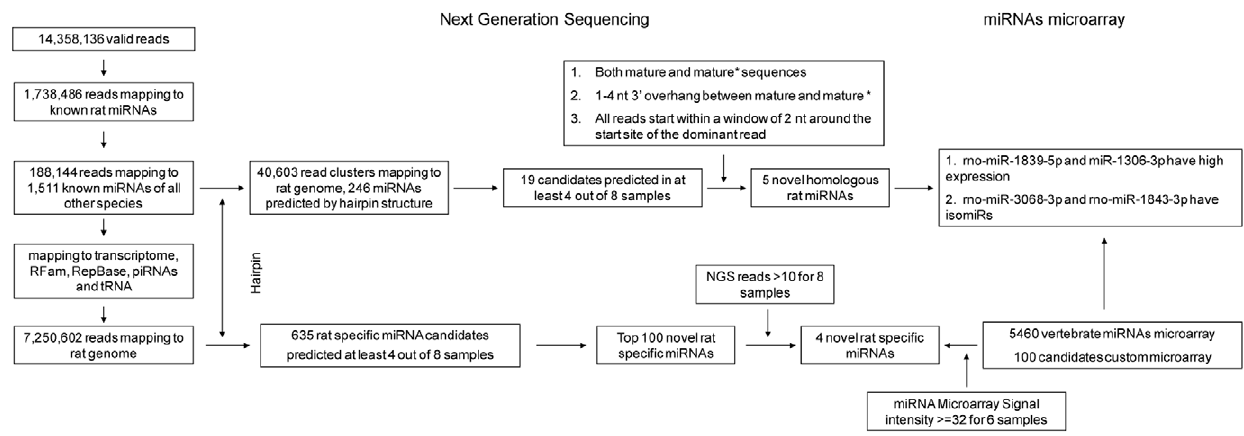
Figure 1. Scheme of the work flow for identifying novel rat miRNAs.